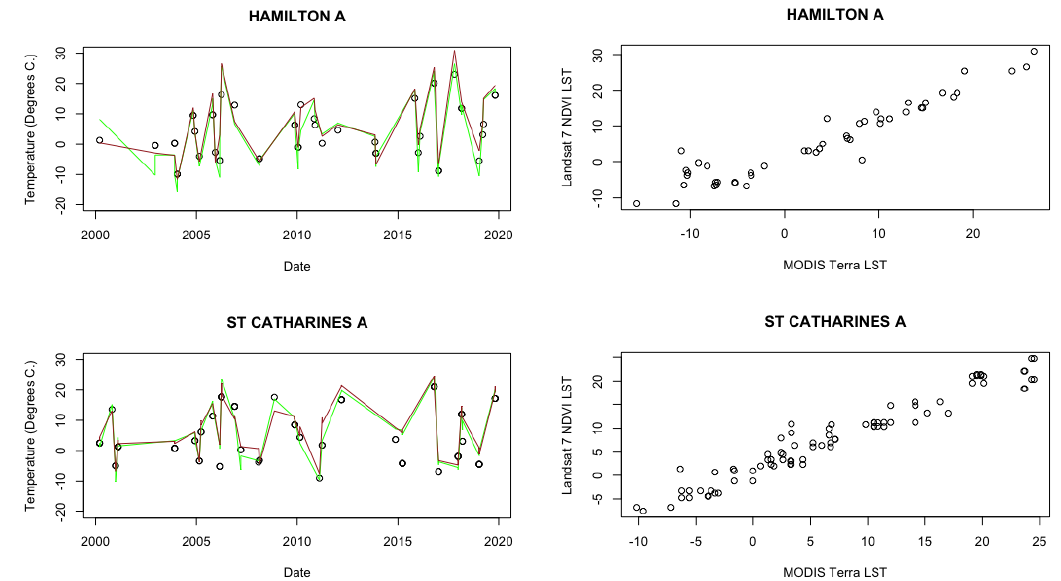
Figure 3. The time series ( left ) and scatterplots ( right ) of the Landsat 7 NDVI-derived LST and MODIS Terra LST along with average air temperature at the stations with the most data points during the winter. The green line represents MODIS LST, the red line represents Landsat 7 LST, and the black points represent average air temperature observations. St Catherines A is an urban station setting and Hamilton A is surrounded with agricultural land.